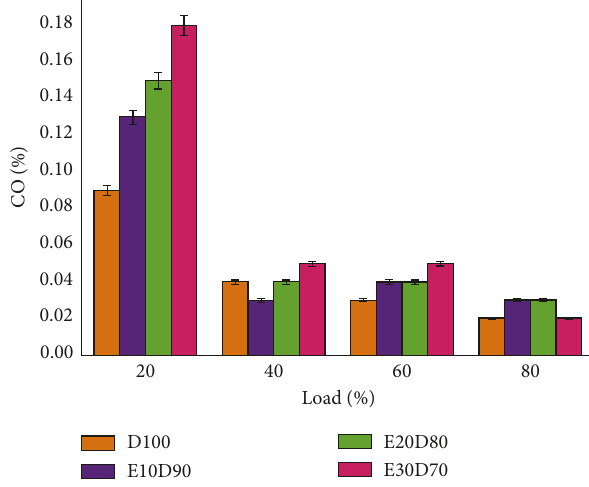
Figure 11: Variation in CO with